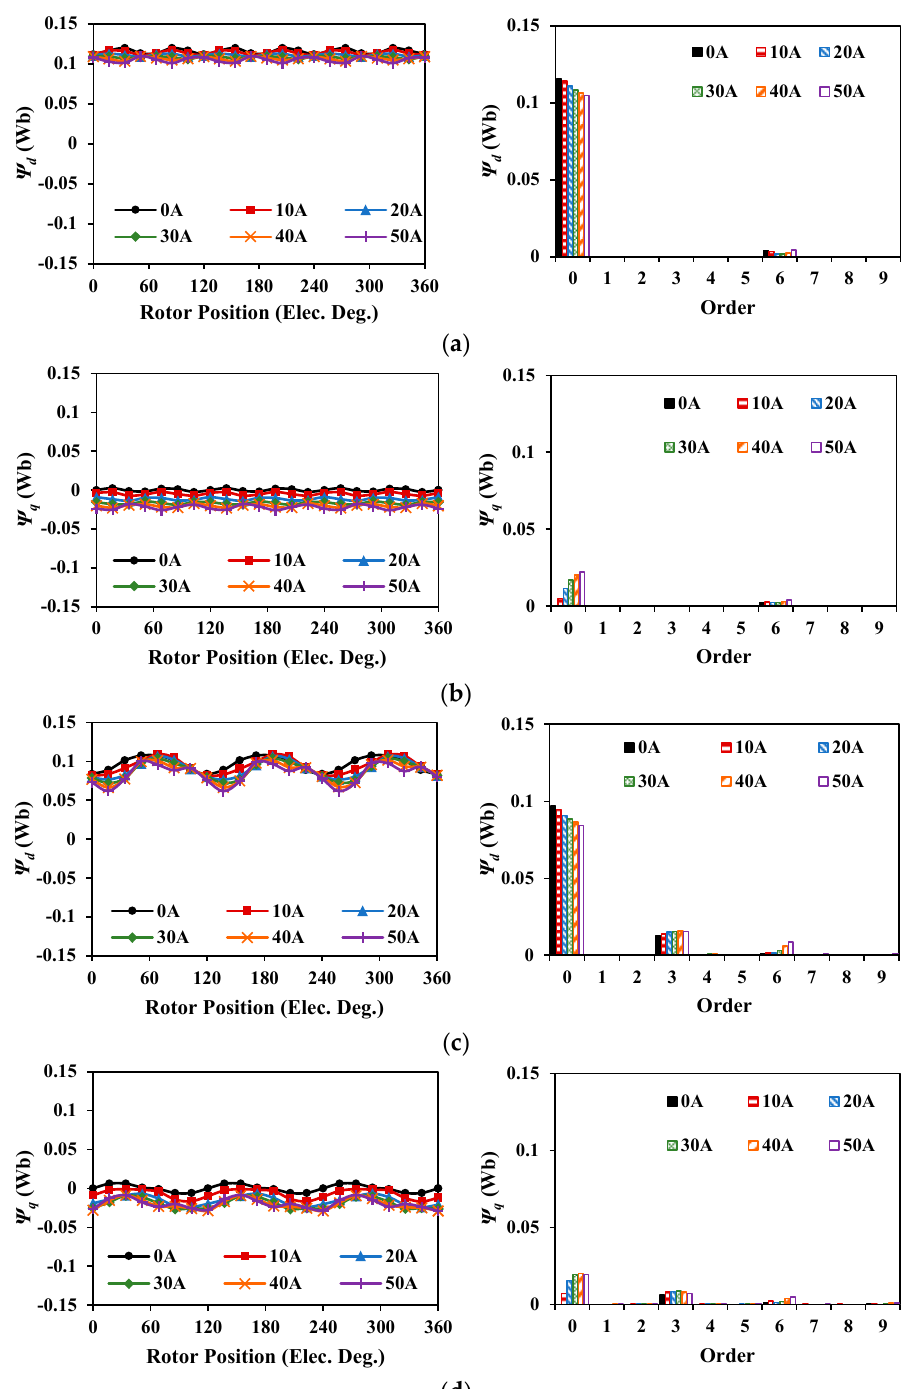
Figure 12. Flux linkages and spectra for 12s8p machines. ( a ) D-axis flux linkage of 12s8p-SPM. ( b ) Q-axis flux linkage of 12s8p-SPM. ( c ) D-axis flux linkage of 12s8p-CCPPM. ( d ) Q-axis flux linkage of 12s8p-CCPPM.